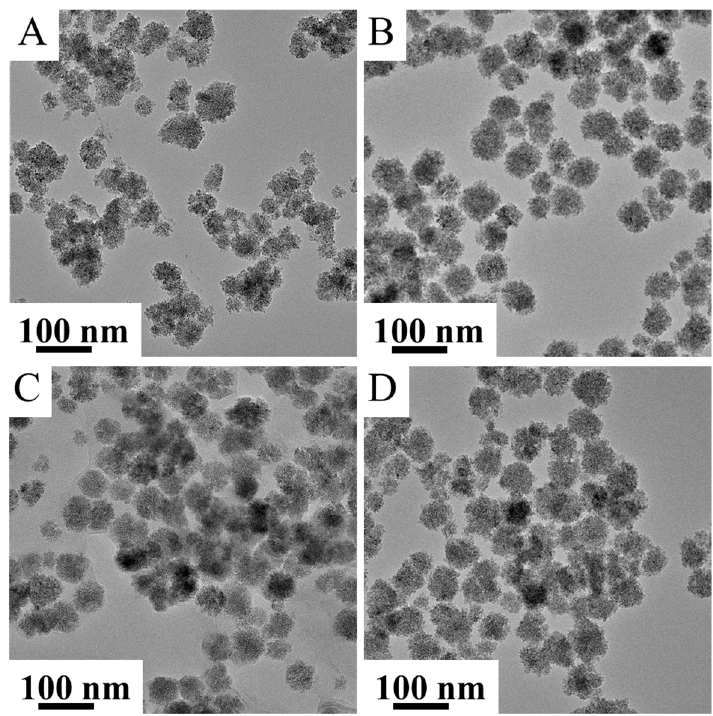
Figure 3. HRTEM picture of the CoFe 2 O 4 -NH 2 ( A ), NiFe2O 4 -NH 2 ( B ), MgFe 2 O 4 -NH 2 ( C ) and MnFe 2 O 4 -NH 2 ( D ) magnetic